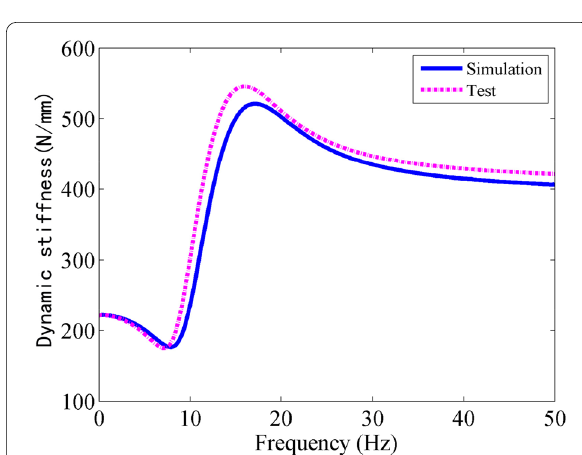
Figure 8 Dynamic stiffness vs. frequency curves